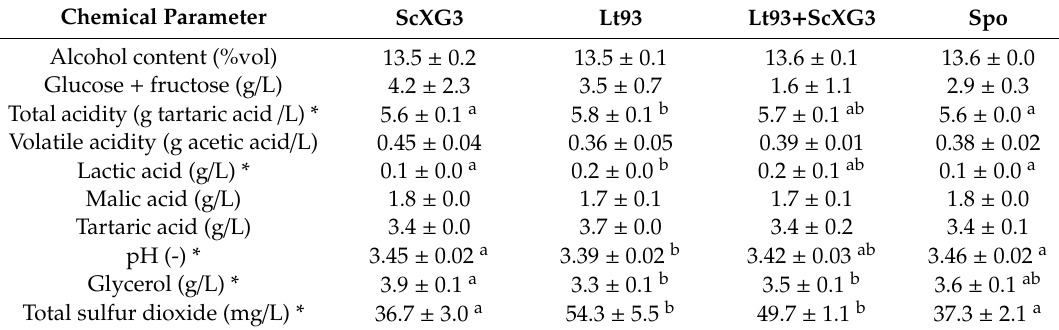
Table 2. Characteristics of Treixadura wines elaborated with S. cerevisiae ScXG3, L. thermotolerans Lt93, sequential fermentation of both strains and by spontaneous fermentation (Spo).